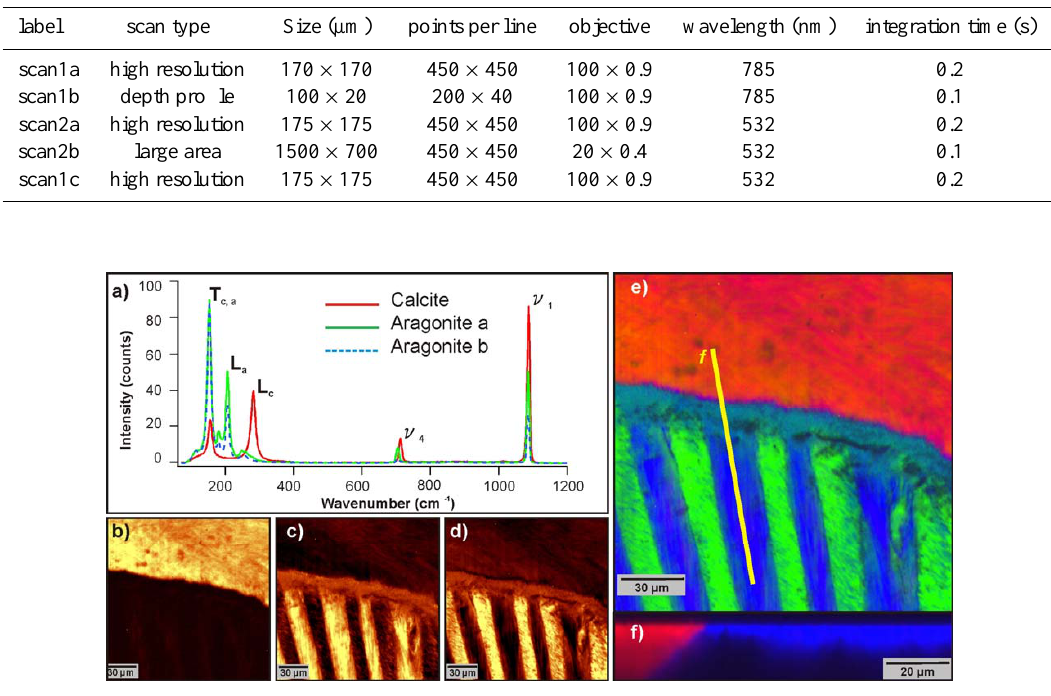
Table 1. Experimental parameters of the different mappings performed by means of confocal Raman microscopy.